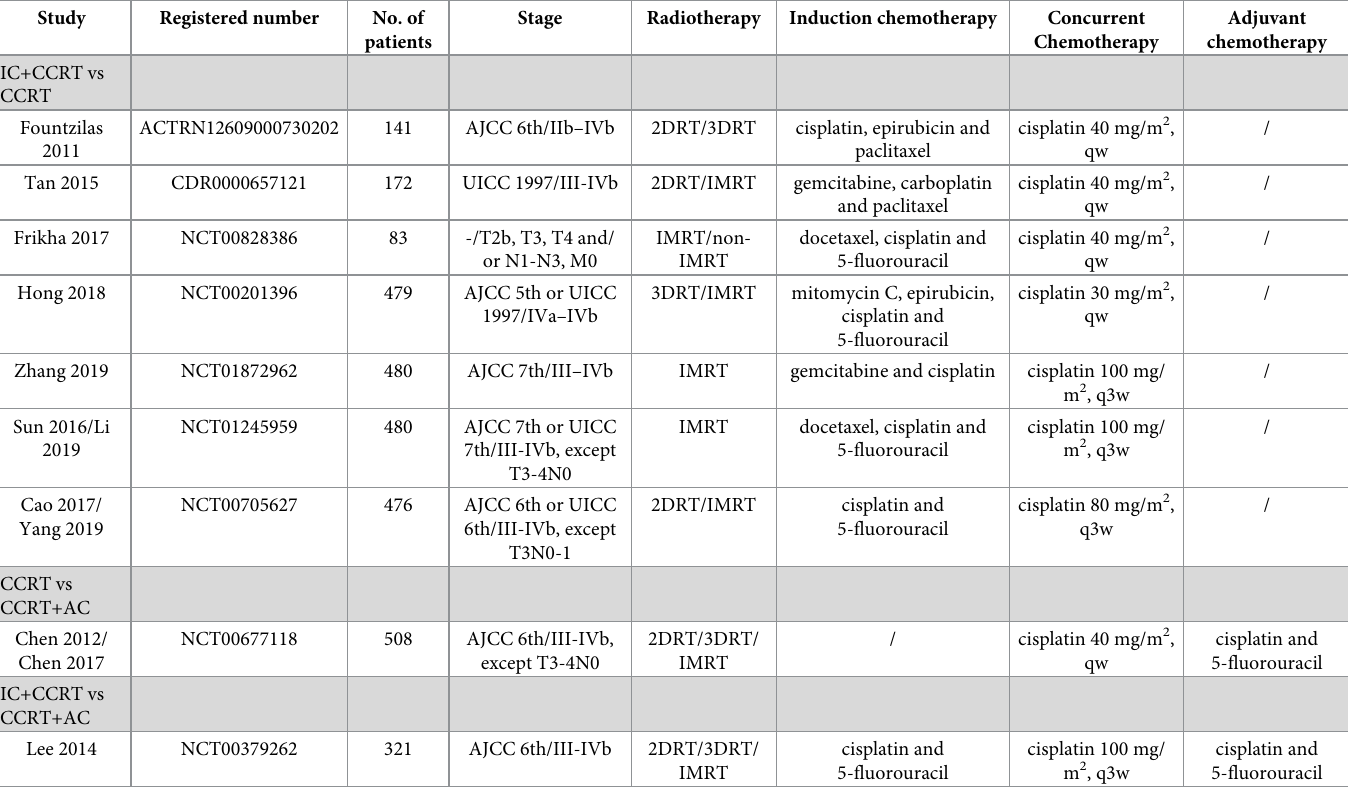
Table 1. Summary of the eligible trials in Bayesian network analysis.